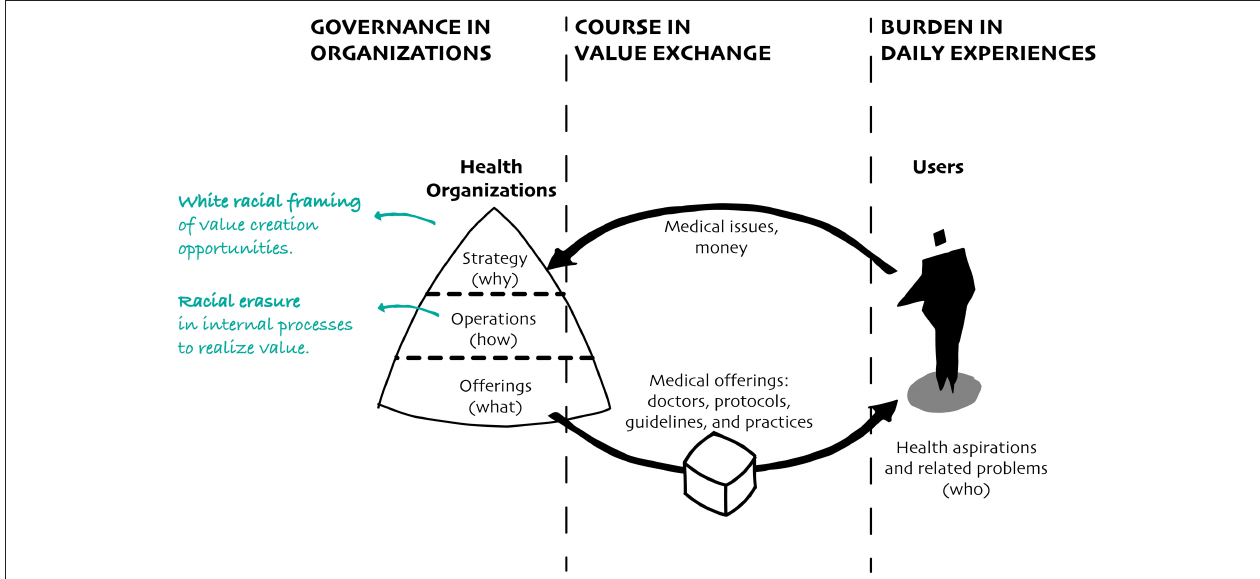
FIGURE 2 | Primarily designed and led by white individuals, health organizations create strategies and operations that respond to why and how they envision value being created to combat